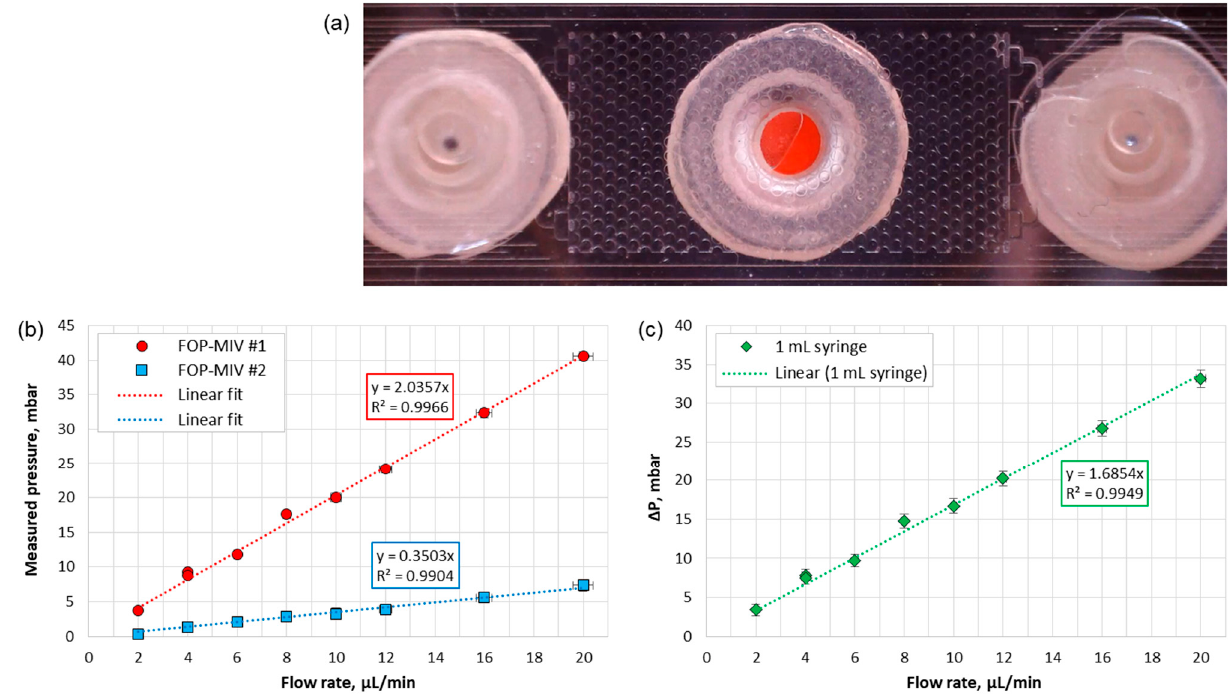
Figure 9. ( a ) Snapshot of the pattern taken when the flow rate of water was 20 µ L/min, ( b ) pressures at Ports 1 and 2 and ( c ) pressure difference ( ∆ P) measured for different flow rates during the steady flow of water through the microfluidic pattern.